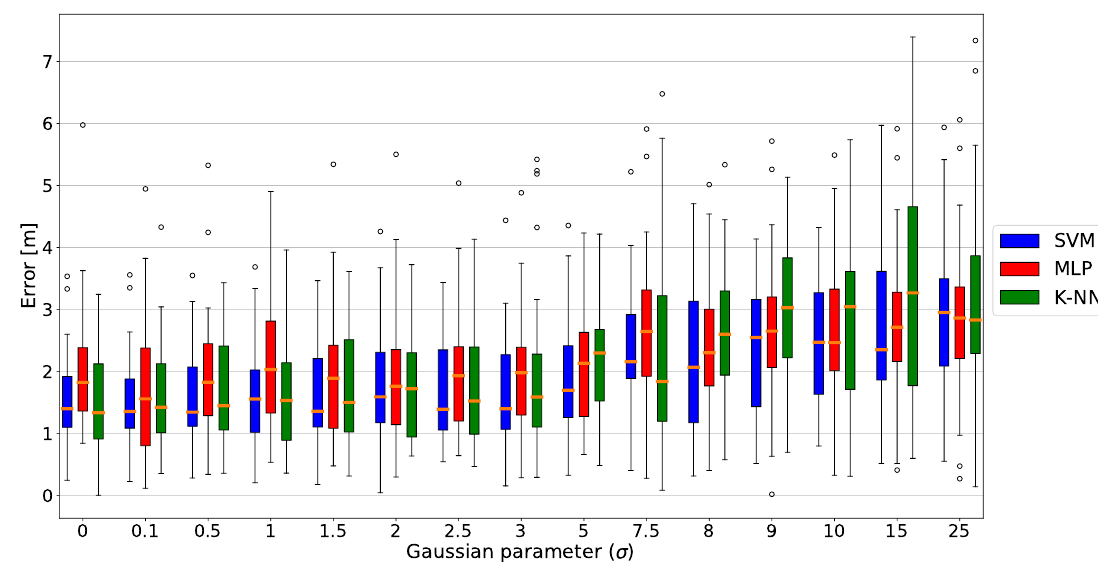
Figure 10. Error box plots for the three fingerprinting algorithms as a function of the standard deviation of the Gaussian noise in Environment A.